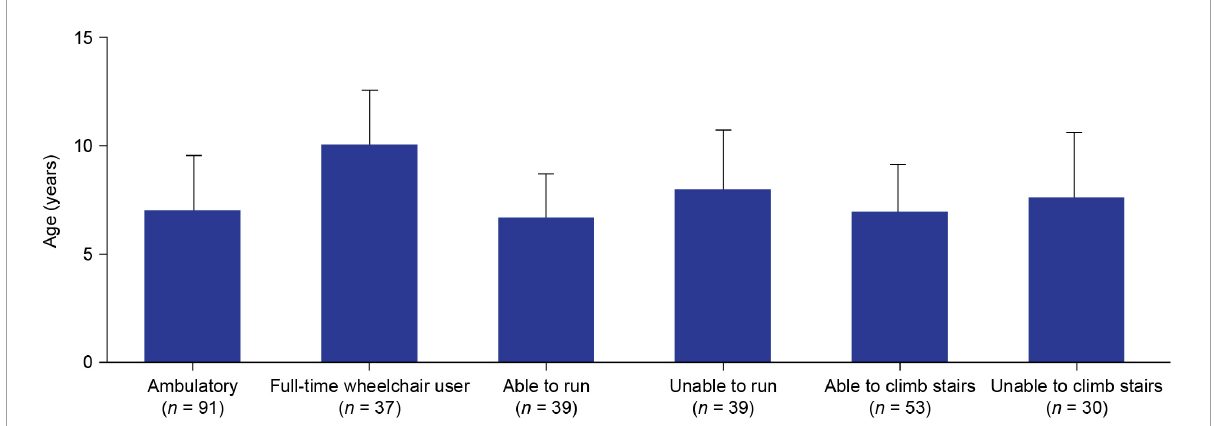
FIGURE3 Mean (SD) age of: ambulatory and full-time wheelchair user patients at enrollment a ; and ambulatory patients who were able and unable to run or climb stairs at enrollment. ‘Ambulatory’ or “wheelchair-use” data were not available for 49/177 patients. “Ability to run” data were not available for 13/91 ambulatory patients. “Ability to climb stairs” data were not available for 8/91 ambulatory patients. a The enrollment visit was the date when the patient visited the study site and had data recorded. SD, standard deviation.